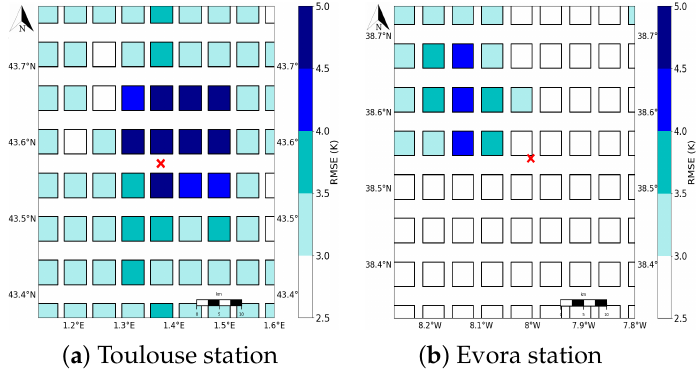
Figure 2. SEVIRI pixel statistics compared to local observations in terms of RMSE for summer period for Toulouse station ( a ) and Evora station ( b ) of the difference between SEVIRI LSTs and the local LSTs. The cross designates the Toulouse Météopole and Evora observation